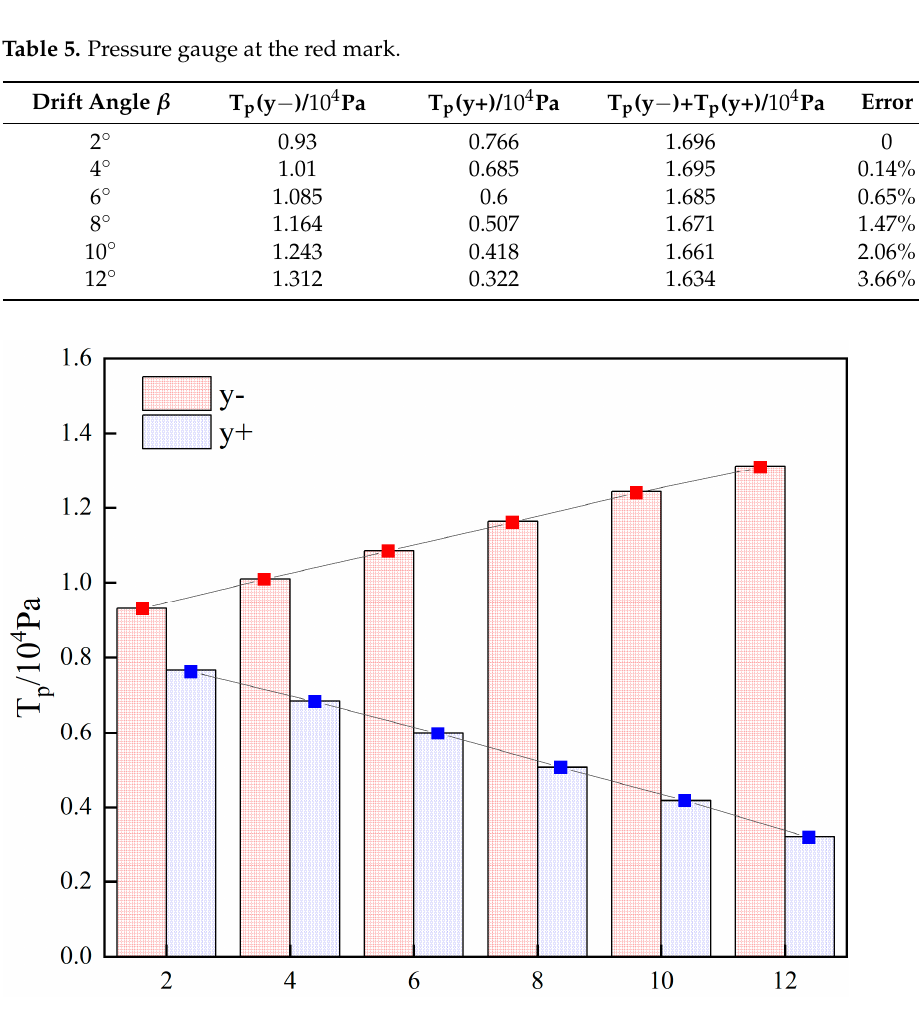
Figure 11. Pressure map comparison at the red mark.